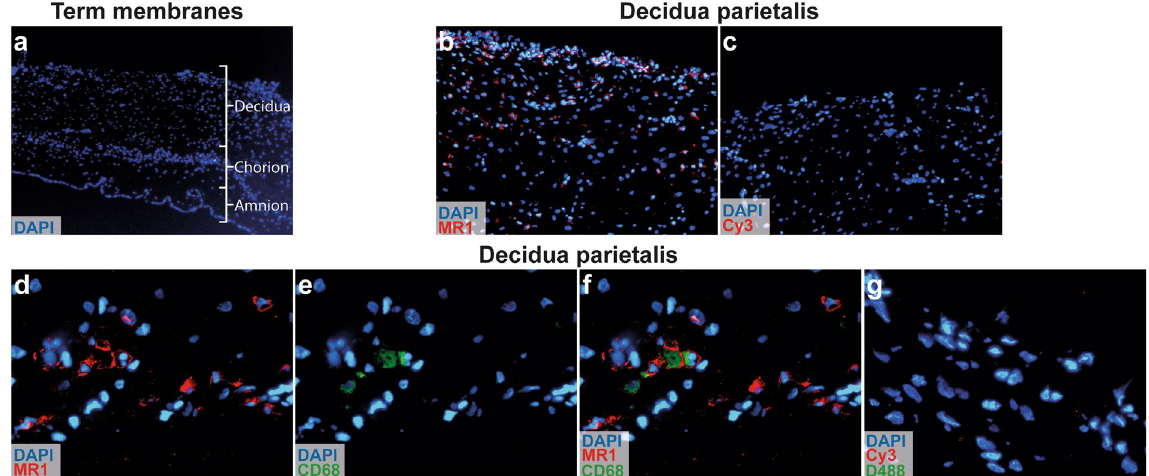
Figure 6. MR1 is expressed by decidual macrophages. ( a ) Immunofluorescence microscopic images of term placental membranes showing cross sections of decidua parietalis, chorion, and amnion at × 4 magnification. ( b ) MR1 staining in the outer decidual layer of the membrane and ( c ) secondary antibody only as control ( × 10). Decidual tissue stained with ( d ) MR1 antibody (red), ( e ) CD68 antibody (green), and ( f ) merged images showing coexpression of MR1 and CD68 ( × 40). ( g ) Sections stained only with secondary antibody (Cy3) and DyLight488-conjugated (D488) streptavidin complex were used as negative controls ( × 40). Nuclei were stained with DAPI (blue). The same microscopy settings were kept for the samples and the corresponding controls, n =